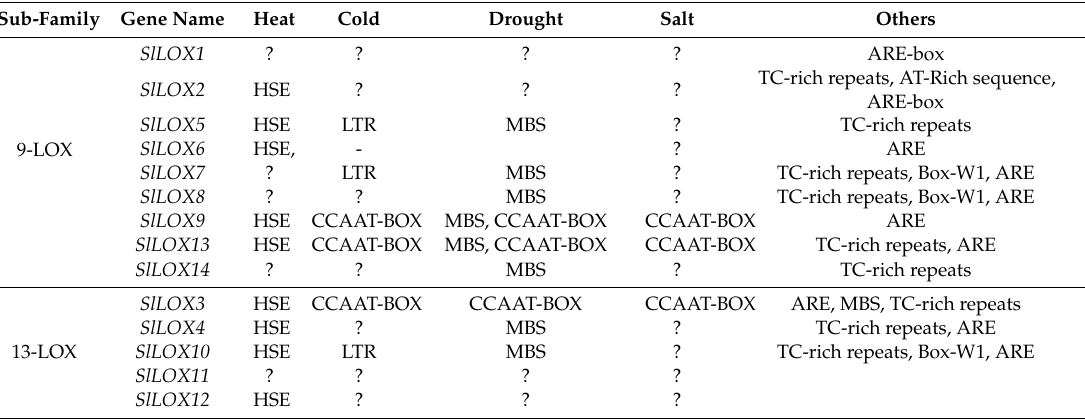
Table 1. Identification of the abiotic stress response cis-elements in tomato ( Solanum lycopersicum L.) 9-LOX and 13 LOX sub-family genes used in this